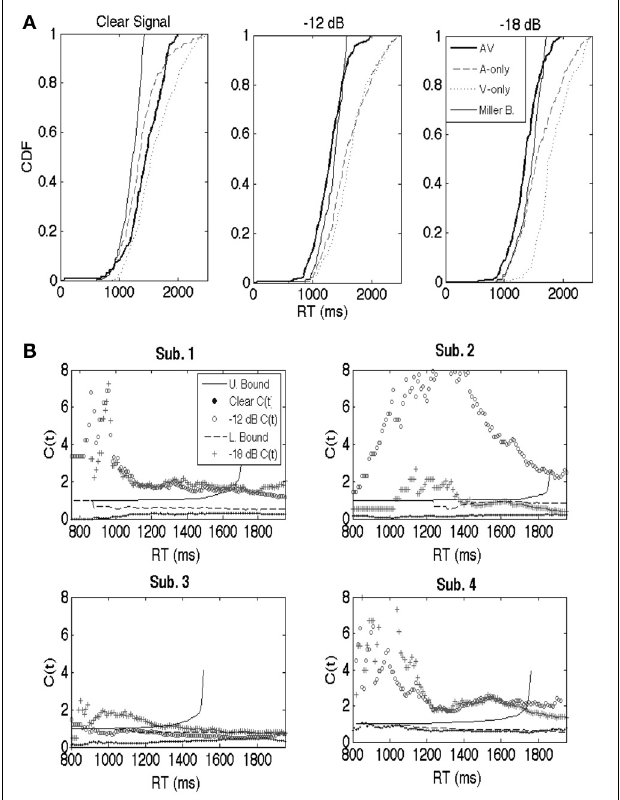
FIGURE 2 | (A) For purposes of illustration, cumulative distribution functions (CDFs; participant 4) are shown separately for the auditory-only, visual-only, and audiovisual trials for the clear, − 12dB, and − 18dB listening conditions. Miller and Grice bounds are plotted as well. (B) Similar to the CDFs, capacity is a continuous function. Results are shown separately for participants 1 through 4. Participant 1’s results are shown in the upper left, 2’s in the upper right, 3’s in the lower left, and 4’s in the bottom right. Each panel displays C(t) across each listening condition, as well as the upper (Miller) and lower (Grice) bounds translated into capacity space (cf. Townsend and Eidels, 2011 for equations). The symbols (clear, − 12dB, and − 18dB) denote the values for the capacity function. Note that there should be separate upper and lower for each auditory S/N ratio. Our strategy was to plot the averaged bounds to avoid clutter, although interpretations of the data would not have changed regardless of the bounds